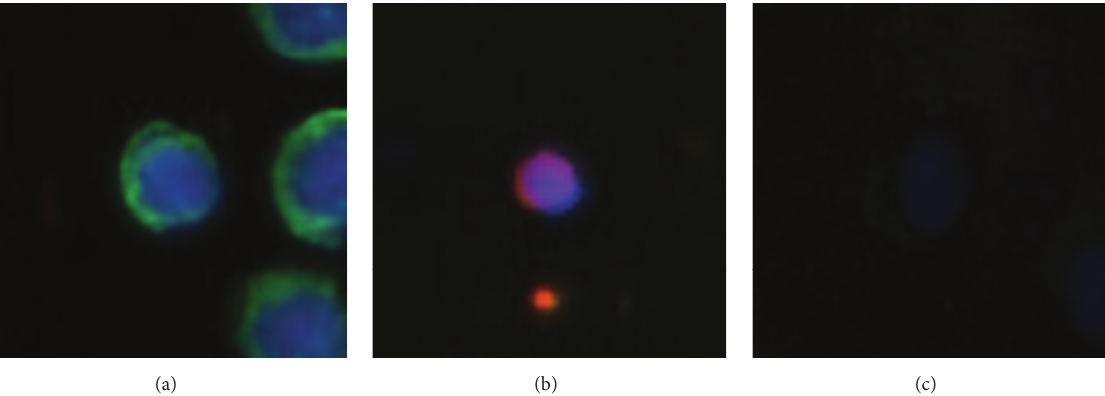
Figure 1: Examples of image cutouts classified with regard to the most central object being a CTC or not. (a) All eleven human observers agree that this is a CTC. (b) All eleven observers agree that this is not a CTC. (c) Six observers classify that this is a CTC while the other five say that it is not a